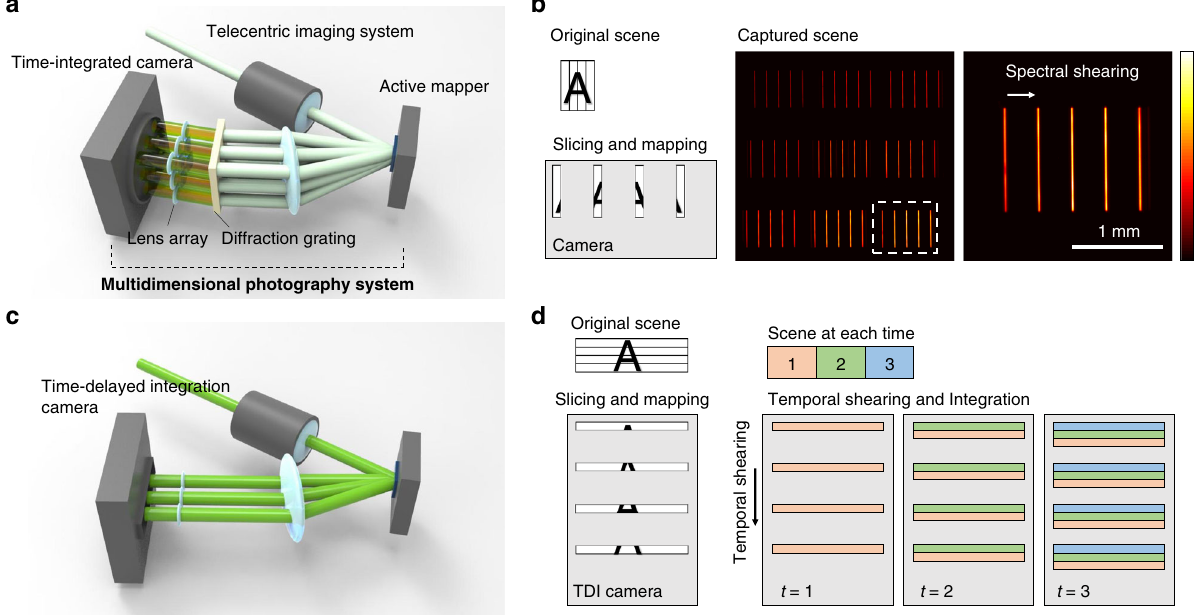
Fig. 2 Demultiplexing a datacube along a speci fi c dimension. a Optical setup for ( x , y , λ ) imaging. The optical setup consists of an active optical mapper, a diffraction grating, and multiscale imaging lenses. b The optical mapper vertically slices and redirects the incident image to reduce the dimensionality of the incident wave. The sliced image is dispersed horizontally by the diffraction grating and mapped onto a time-integrated 2D camera. c Optical setup for ( x , y , t ) imaging. The optical mapper horizontally slices and redirects the incident image onto a time-delay integration (TDI) camera. d Operating principle of the TDI camera. TDI camera temporally shears the incident light signal along a spatial axis and integrates the signal along a temporal axis. the information dimensionality and allowing the light datacube to spatial phase map of the light wavefront determines its propa- be measured with a 2D image sensor. The schematic is shown in gation direction, the re fl ected light from the SLM is directed Fig. 2. The front-end optics generates an intermediate image and towards varied angles. The added phases to the image are thus projects it onto an active optical mapper, the SLM, which imposes transformed to the angles of outgoing rays, tearing apart the light a programmed phase map on the incident light. Because the datacube in the angular domain. To reimage the modulated light